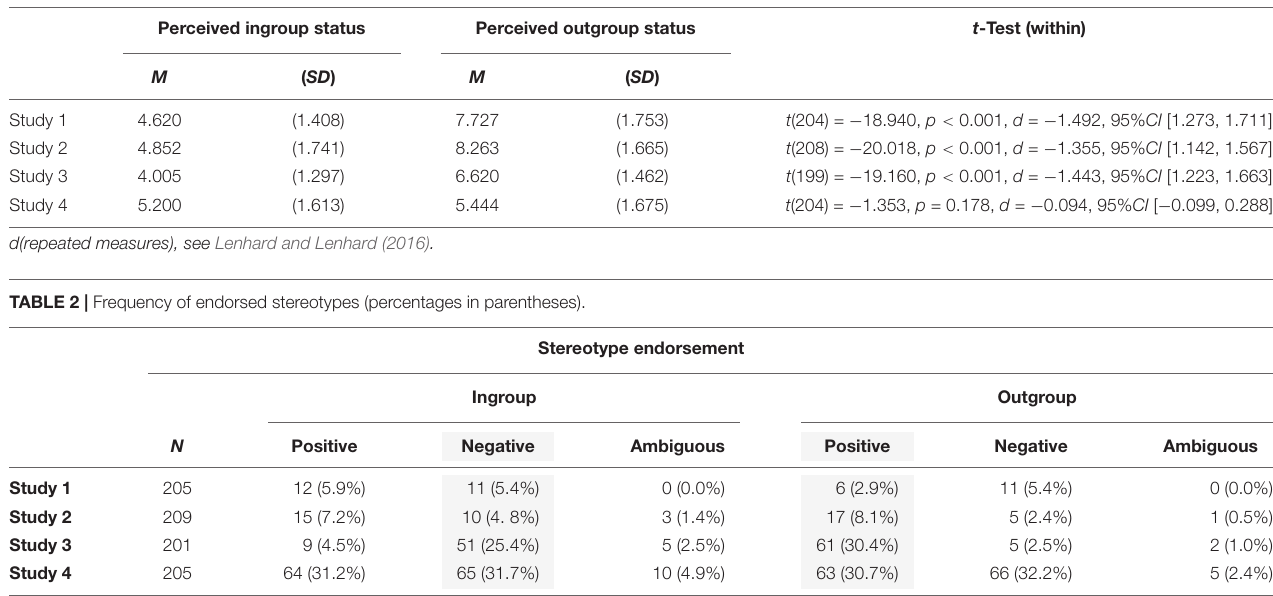
TABLE 1 | Group status perceptions.